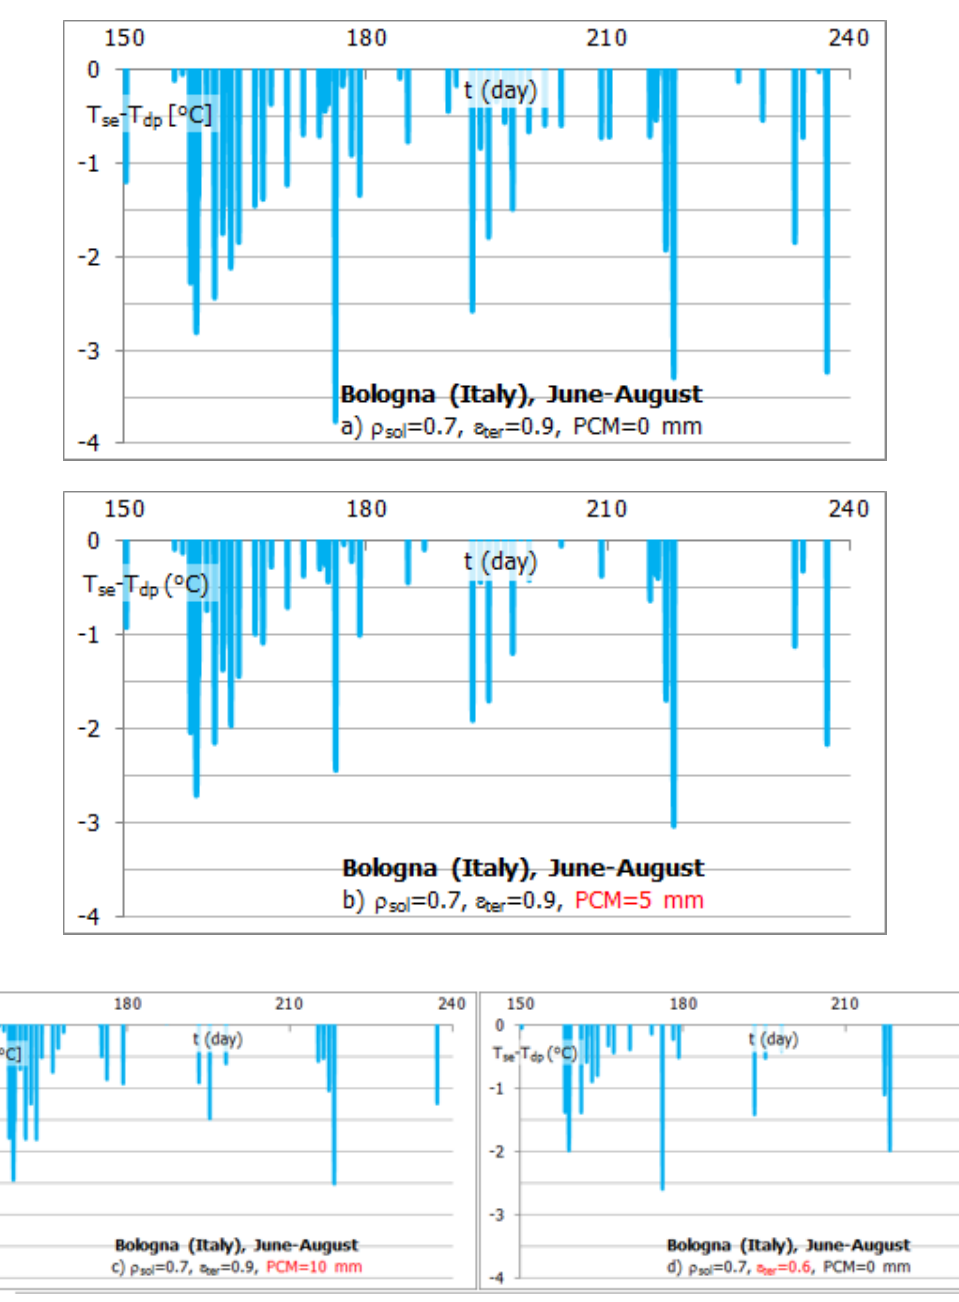
Figure 6. Risk of condensation for a) a typical cool roof, b) a cool roof coupled with 5 mm PCM, c) a cool roof coupled with